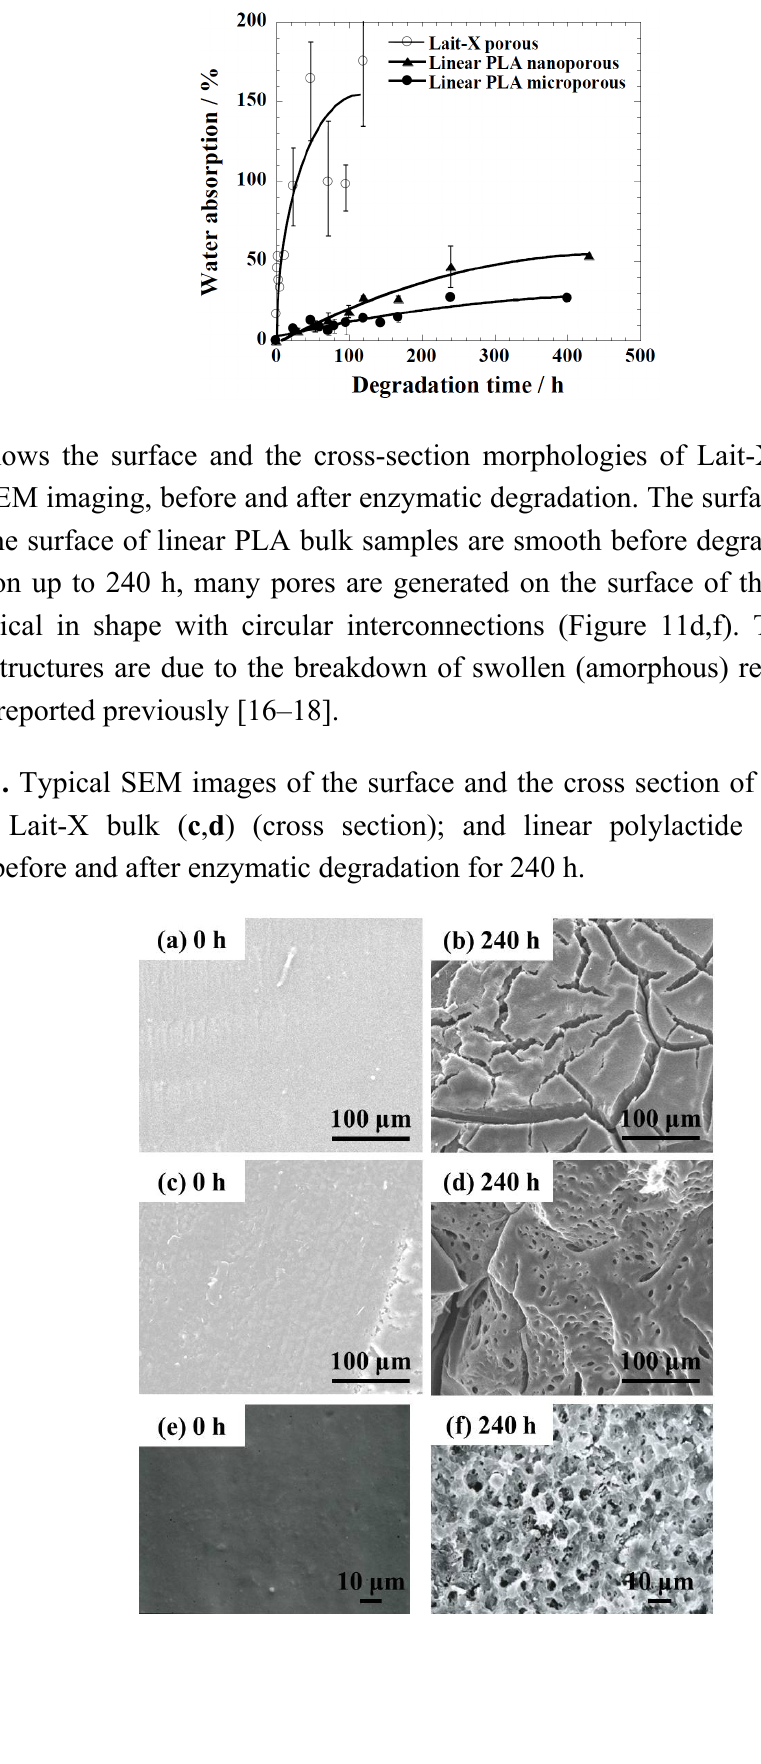
Figure 10. Water absorption changes of linear polylactide (PLA) having nanoporous and microporous structures, and Lait-X having a porous structure during enzymatic degradation at 37 °C.